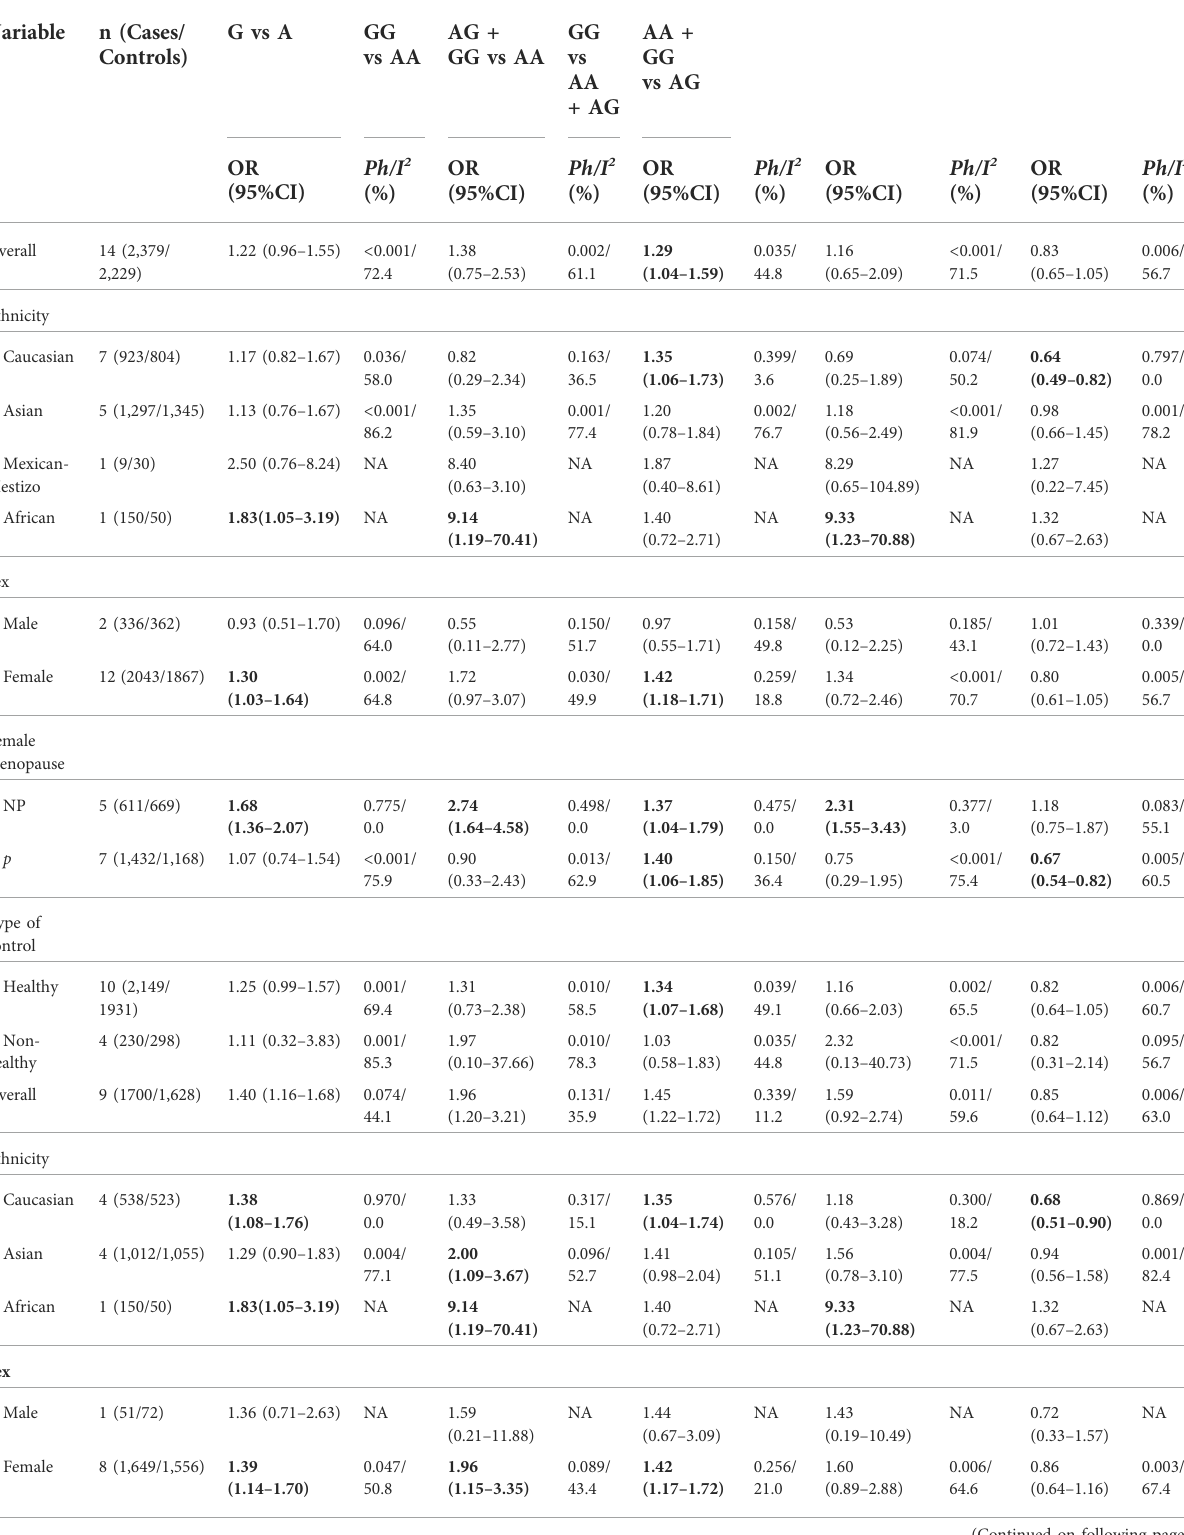
TABLE 1 Meta-analysis of the association of OPG A163G polymorphism with risk of osteoporosis.